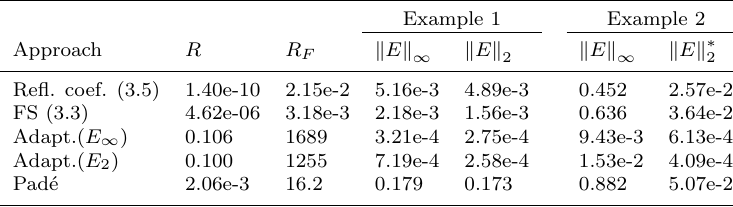
Table 6. Values of all objective functions obtained with different approaches Example 1 Example 2